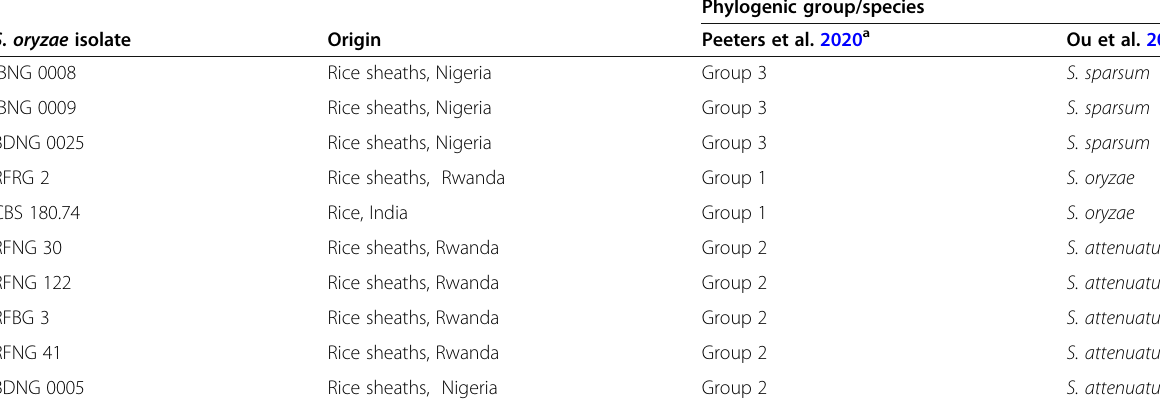
Table 1 Characteristics of the Sarocladium isolates used in this